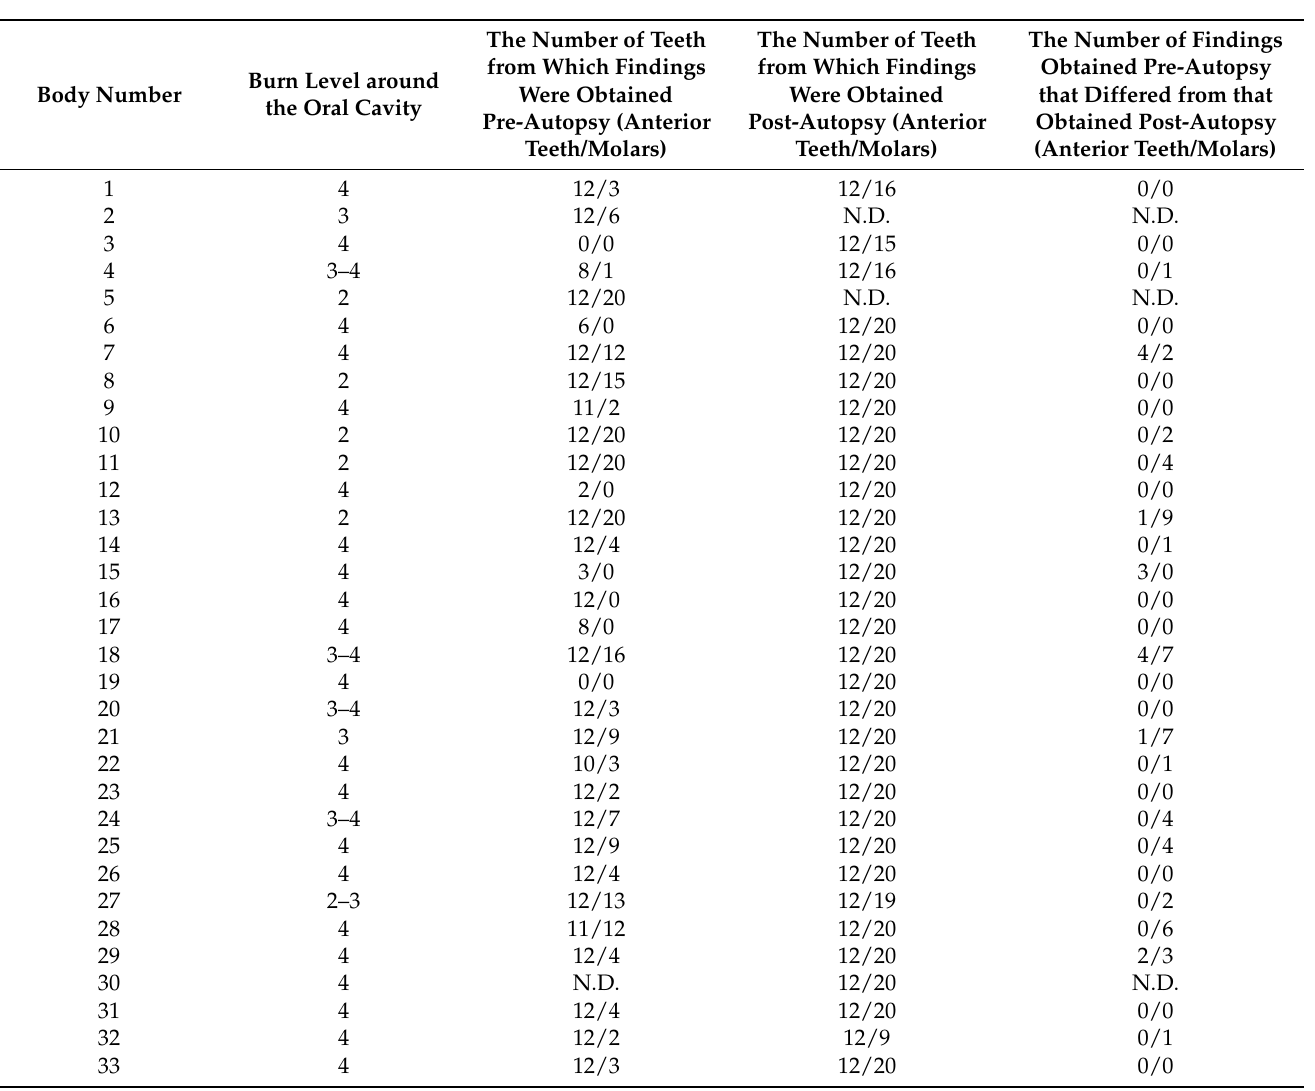
Table 3. The number of teeth findings obtained pre- and post-autopsy, the number of different findings obtained pre- and post-autopsy, and the burn levels around the oral cavity in all bodies with dental findings, with body numbers assigned